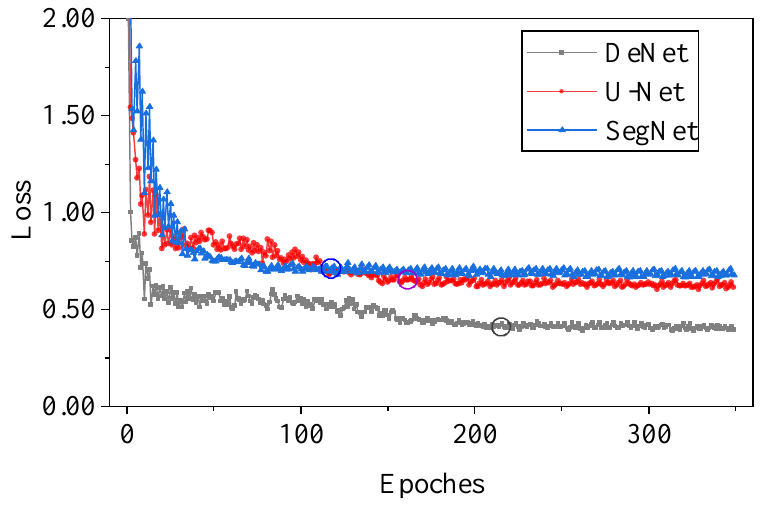
Figure 4. The loss changes in model training of three models with the blue, purple, and black circles indicate the general locations of model convergence for SegNet, U-Net, and DeNet, respectively.